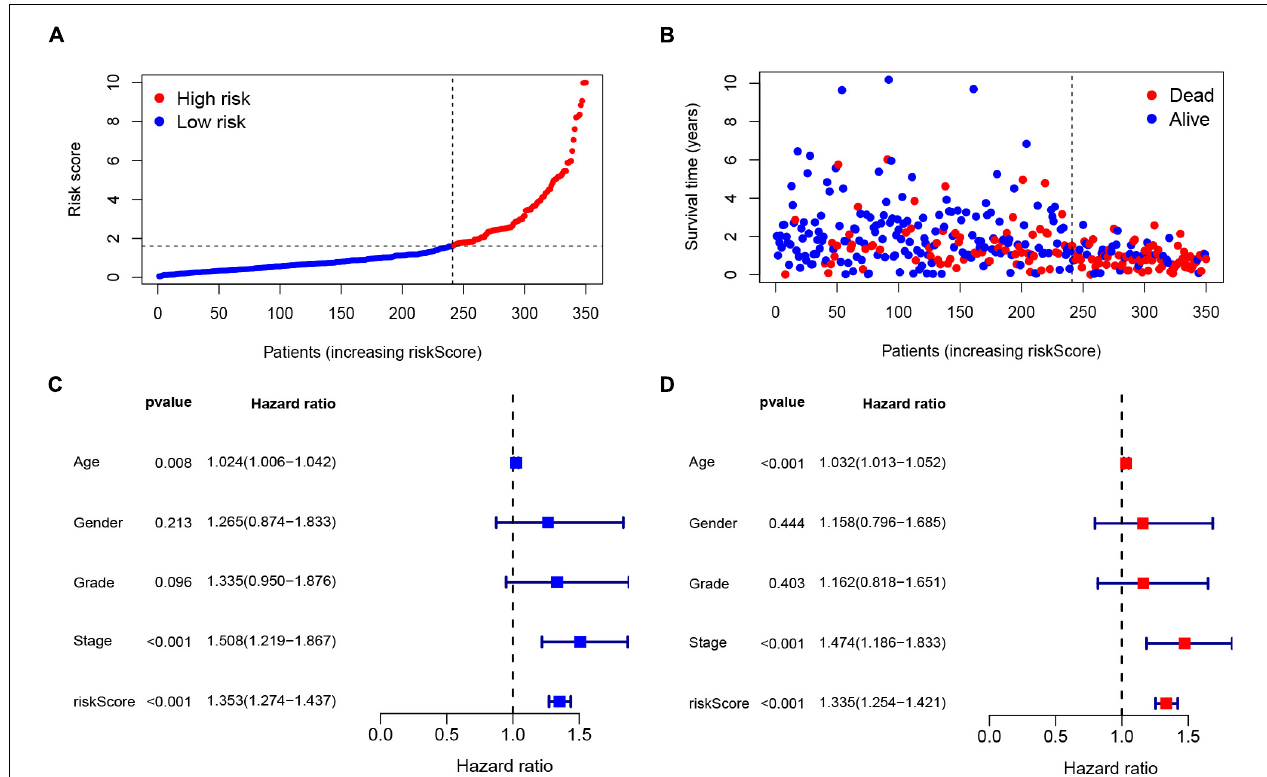
FIGURE 4 | Validation of the IRlncRNAPs signature. (A) RiskScore distribution of GC patients. (B) Survival status of GC patients with increasing riskScore. (C) Univariate and (D) multivariate Cox regression analyses of the